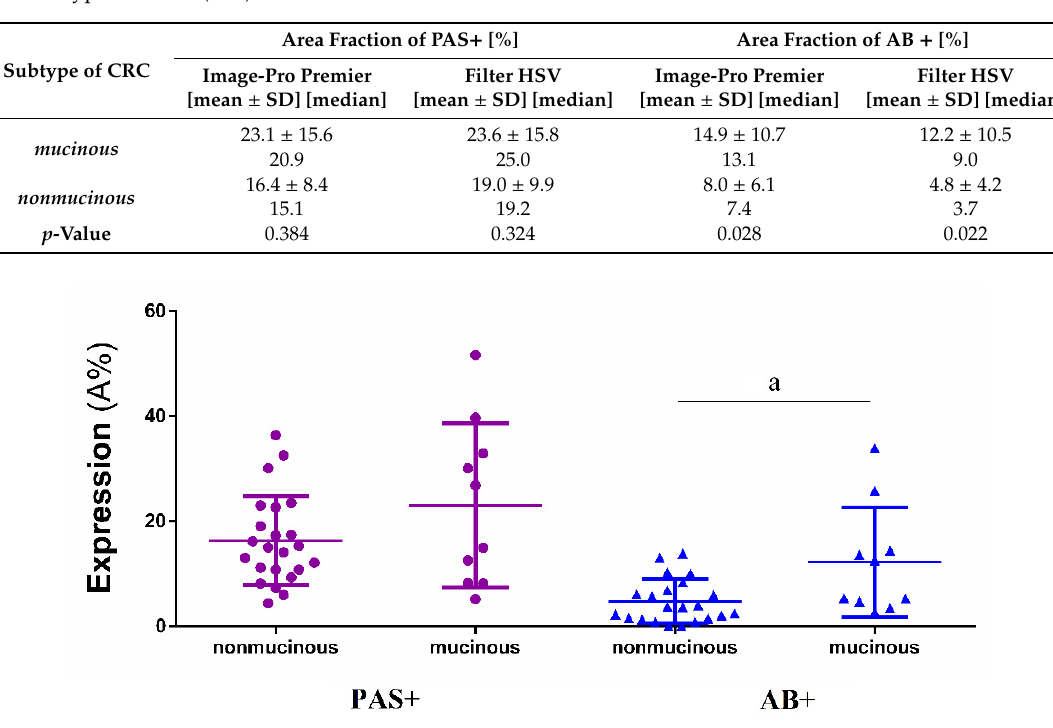
Figure 3. Comparative histochemical expression of PAS+ and AB+ polysaccharides (mean ± SD) in nonmucinous and mucinous subtypes of colorectal carcinoma. PAS+—periodic acid Schiff positive reactivity; AB+—alcian blue positive reactivity, a—significance = 0.028. Table 3. Comparison of PAS+ and AB+ polysaccharides expression in mucinous and nonmucinous subtypes of CRC (A%).